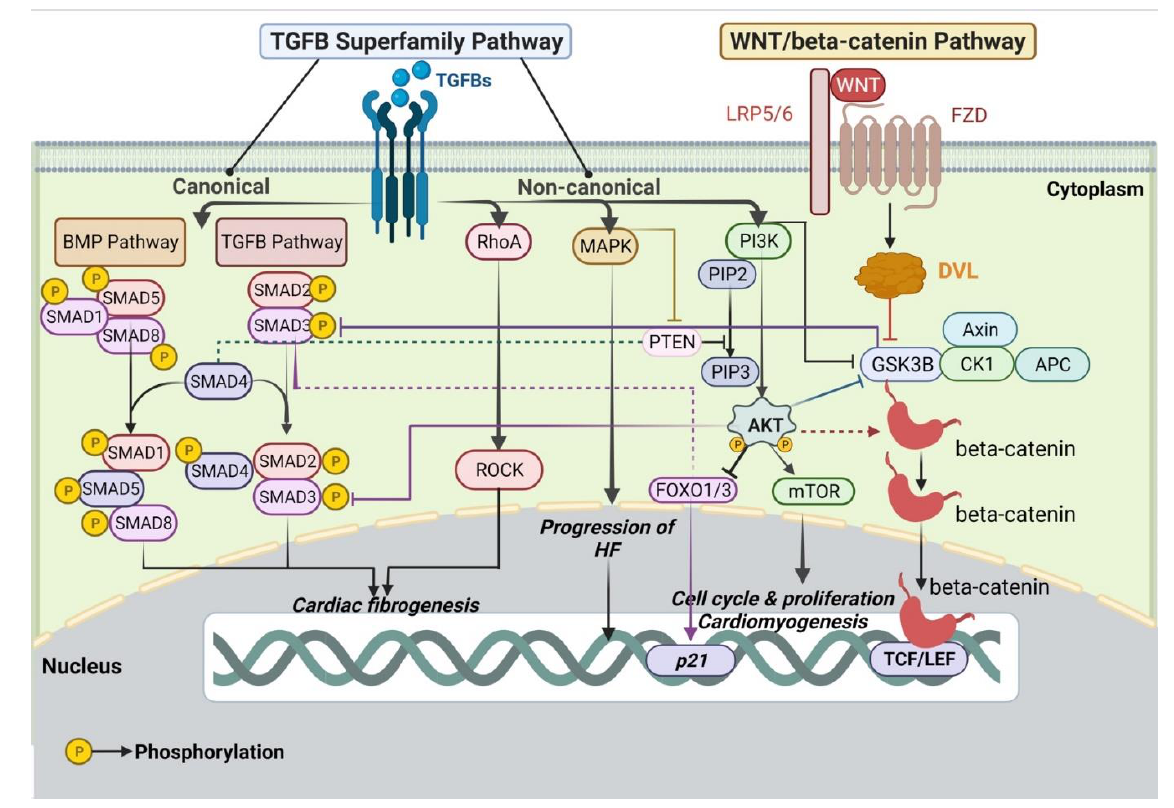
Figure 2. Illustration of the interconnecting networks between WNT, TGFB, PI3K/AKT/mTOR, and MAPK pathways. The figure is broadly discussed in the main text. The black arrows designate main signaling pathways; the dashed arrows indicate activation; the continuous blunt-ended arrows pin- point inhibition. AKT: v-akt murine thymoma viral oncogene homolog/Protein kinase B; APC: Ad- enomatous polyposis coli; BMP: Bone morphogenetic protein; CK1: Casein kinase 1; FOXO1/3: Fork- head box proteins O1/3; FZD: Frizzled; GSK3B: Glycogen synthase kinase 3 beta; HF: heart failure; LRP5/6: Lipoprotein receptor-related protein 5/6; MAPK: Mitogen-activated protein kinase; mTOR: mammalian target of rapamycin; PI3K: phosphatidylinositol 3-kinase; PIP2: Phosphatidylinositol-4,5-bisphosphate; PIP3: Phosphatidylinositol-3,4,5-triphosphate; PTEN: Phosphatase and tensin homolog deleted on chromosome 10; ROCK: Rho-associated protein kinase; SMAD: Small mothers against decapentaplegic; TCF/LEF: T cell factor/Lymphoid enhancer factor; TGFB: Transforming growth factor beta. Created with https://biorender.com/, accessed on 30 April 2022.